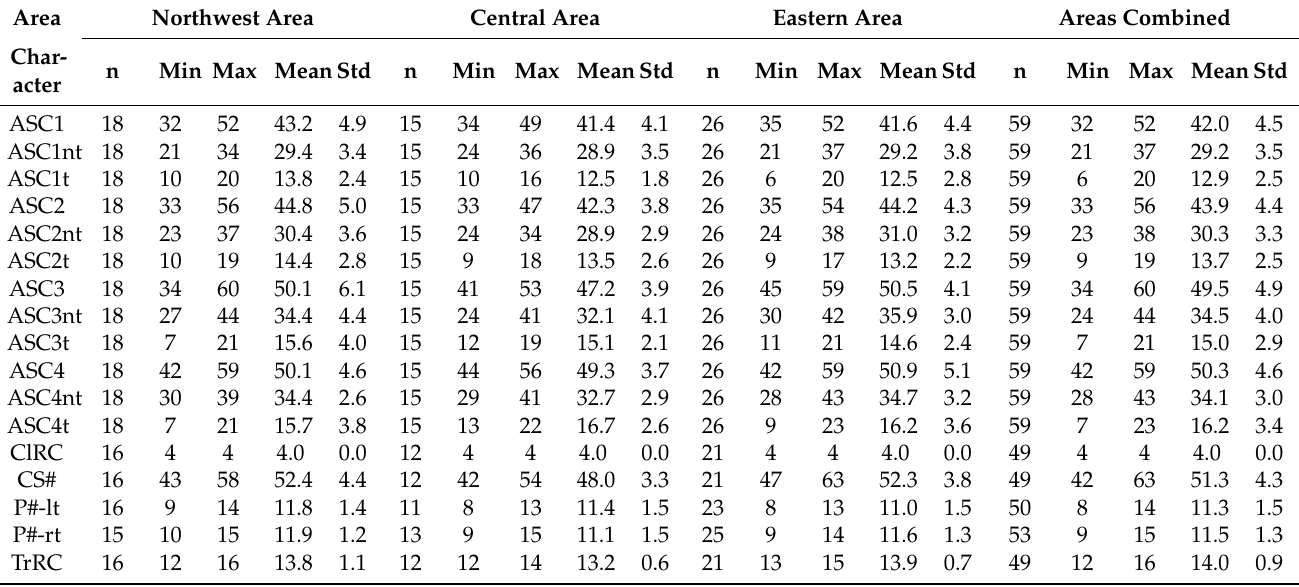
Table A5. Meristic counts for female Sepia typica. Sample size ( n ), minimum (Min), maximum (Max), arithmetic mean (Mean) and standard deviation of the mean (Std) are presented by region and for all regions combined for each character (See Table A1 for character